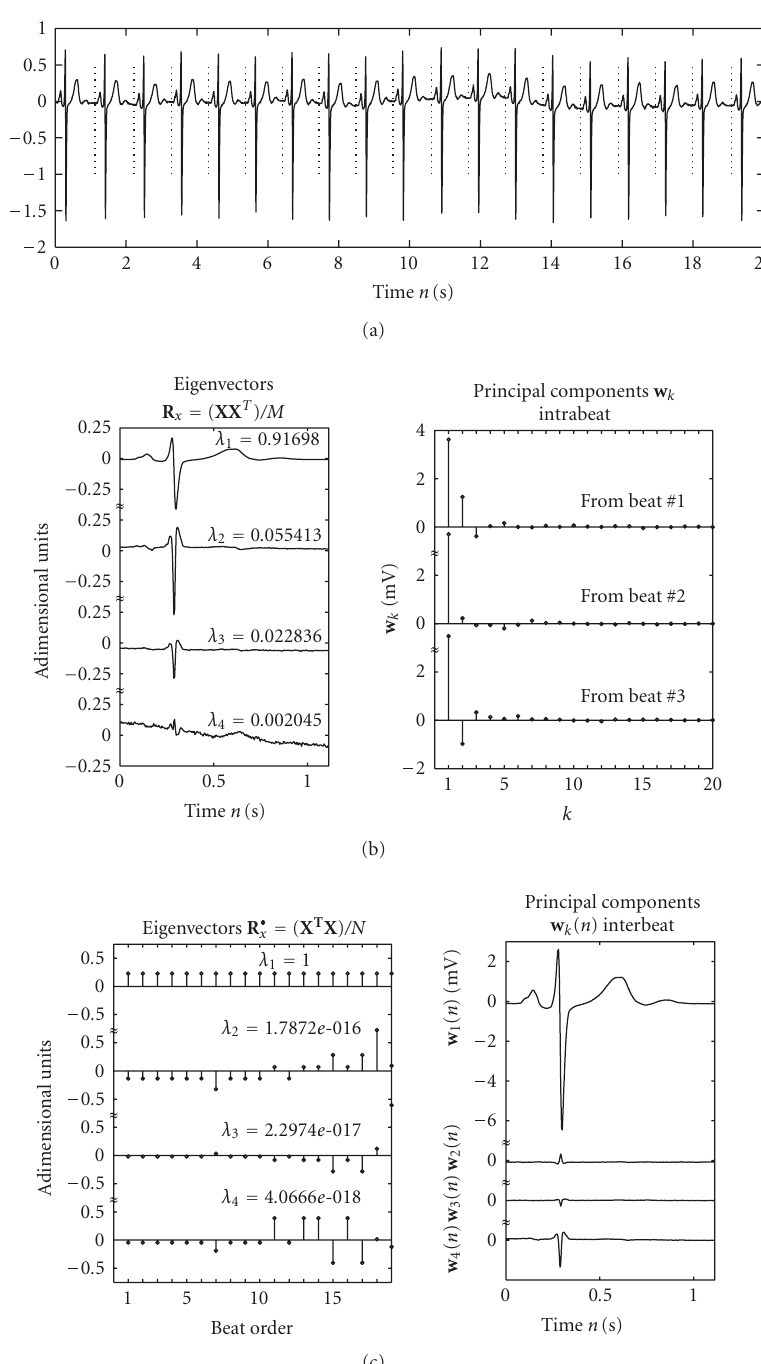
Figure 1: Transform-based representation of an ECG signal (a) segmented to include the whole beat (vertical lines) and produce the data matrix X . The eigenvectors (apart from a DC level) and principal components are displayed for (cid:12) R x obtained as (b) the intrabeat correlation matrix defined in (7), or (c) the interbeat correlation matrix defined in